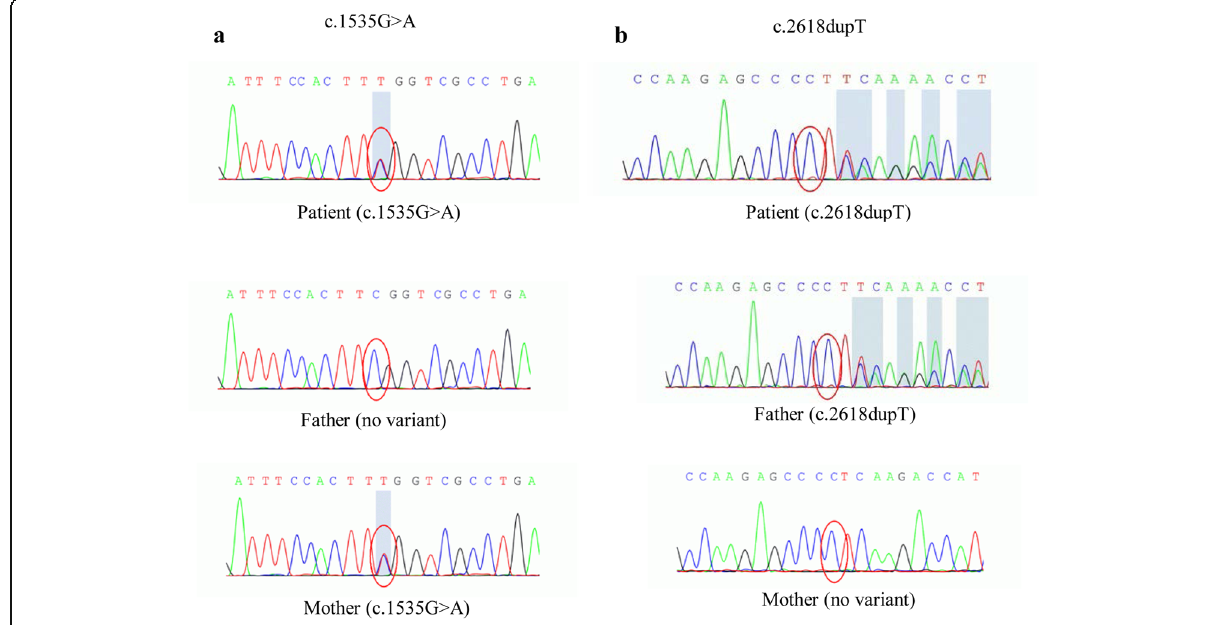
Fig. 3 Sanger sequencing of WDR62 variants of the child patient and his parents. a : The heterozygous mutation c.1535G > A of WDR62 was found in the chr19:36574128 of the child and his mother, but no variant was found at the same locus of his father (circled part); b : The heterozygous mutation c.2618dupT of WDR62 was found in the chr19:36590397 of the child and his father, but no variant was found at the same locus of the mother (circled